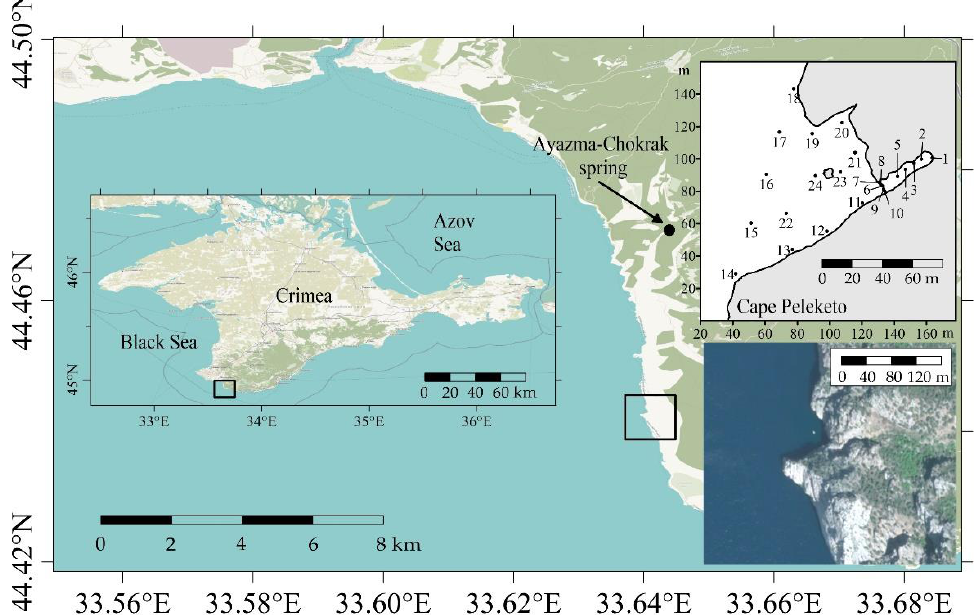
Figure 2. Location and layout of sampling stations.